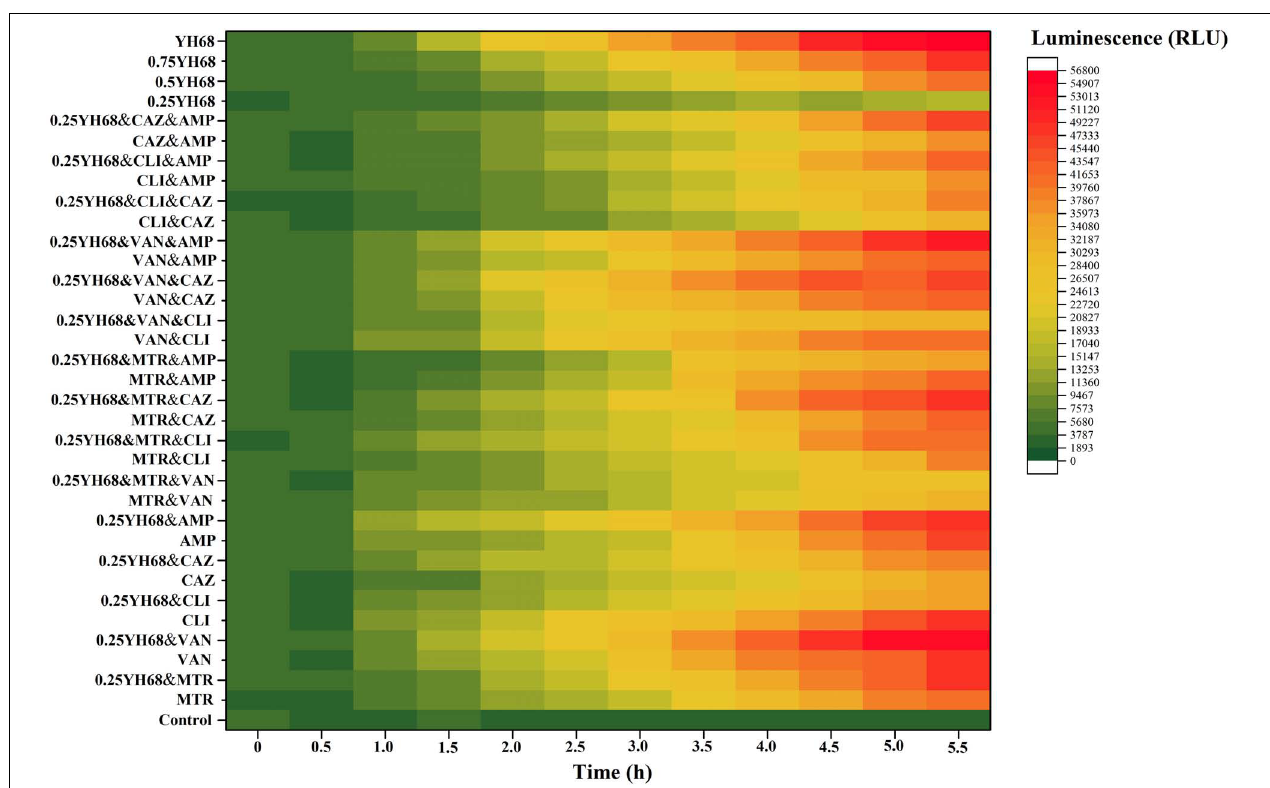
FIGURE 3 | Effects of different combinations on extracellular ATP levels of C. difficile ATCC